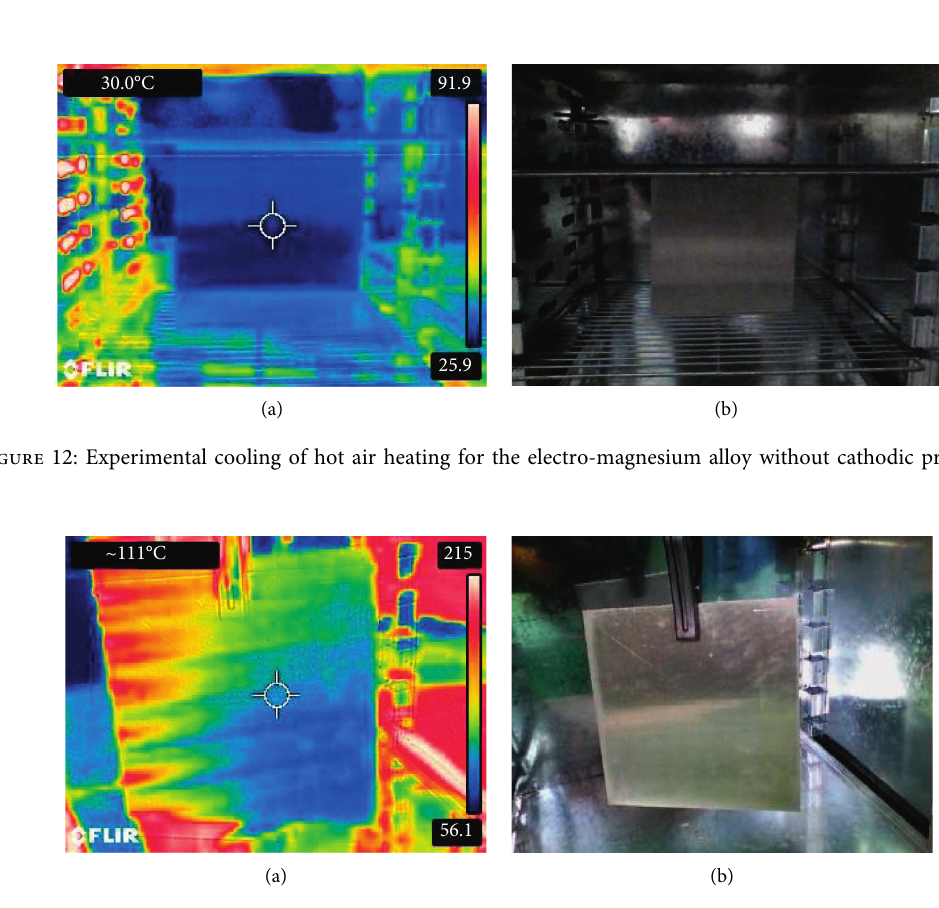
Figure 13: Hot air heating experiment of the electro-magnesium alloy with cathodic